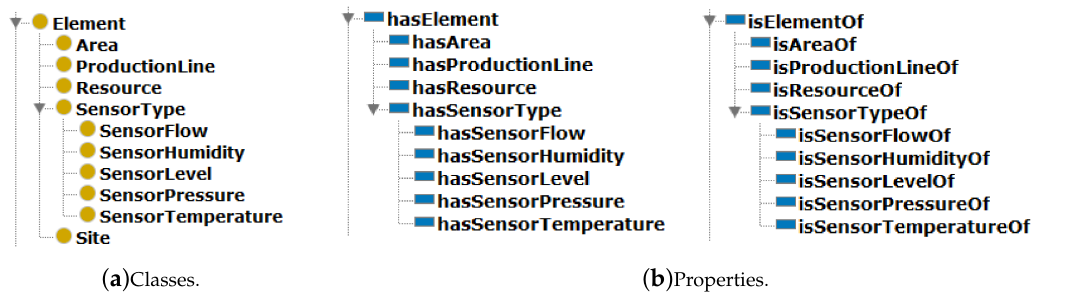
Figure 4. Classes (yellow) and Properties (blue) of module Element .